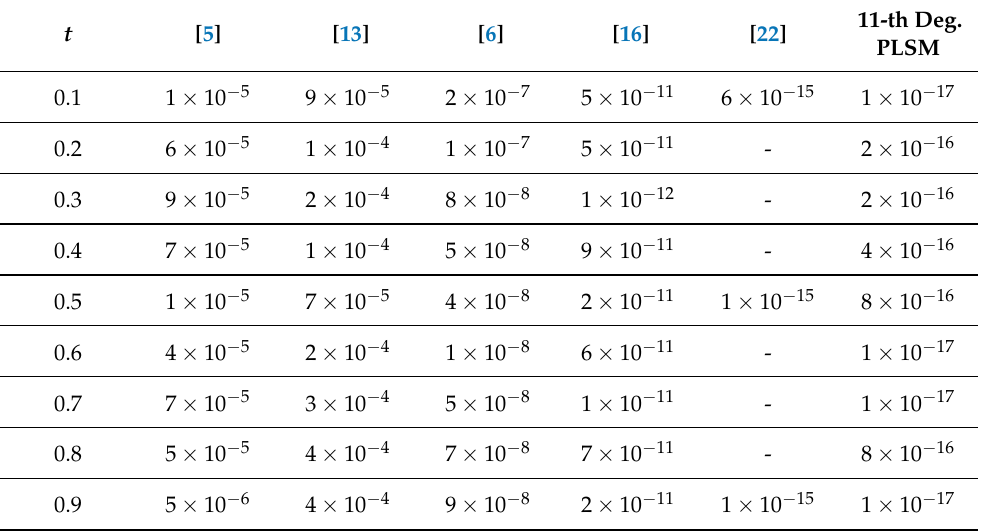
Table 1. Comparison of absolute errors of x 1 for problem (17) in the case α 1 = α 2 =